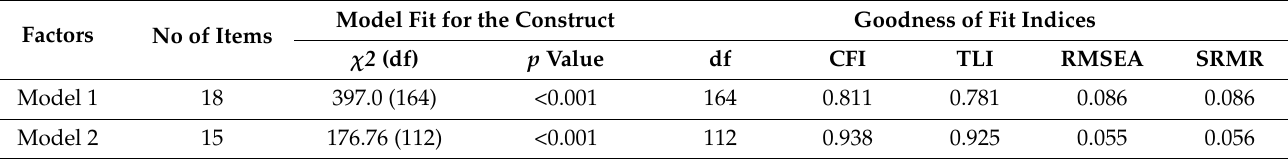
Table 6. Final model’s factor loadings.